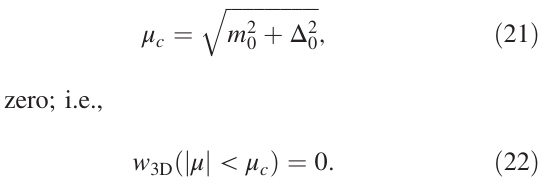
FIG. 4. Energy gap d the inner (a) and outer (b) Fermi surfaces for v 2 ¼ 3 v 1 . Those for v 2 ¼ 3 v 1 (dashed line) and 4 v 1 (solid line with filled lobe) on the k k cut are displayed in (c). z x